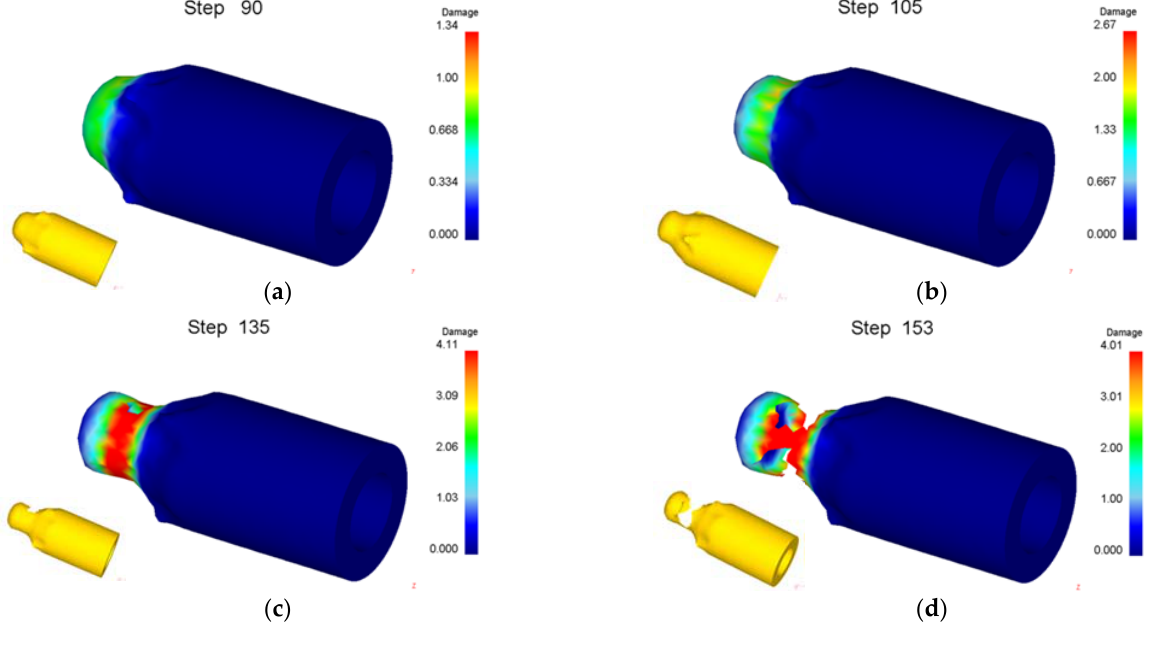
billet wall when the wall thickness is nearly equal to the bottom thickness or the bottom thickness is thick, thus the roll forming can be carried out successfully.